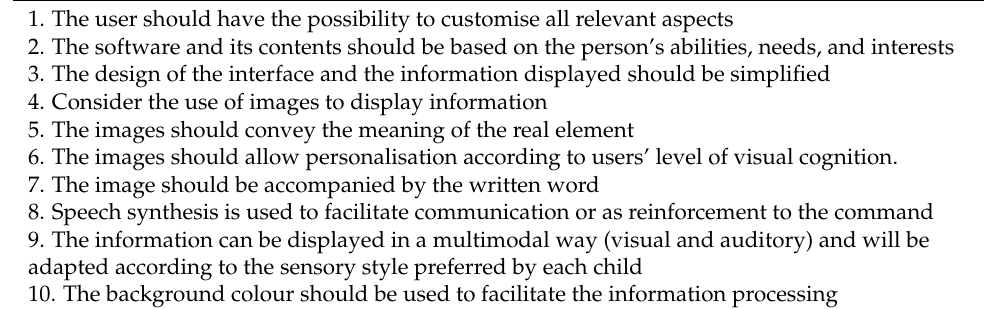
Table 2. Suggested recommendations to support interface design for children with